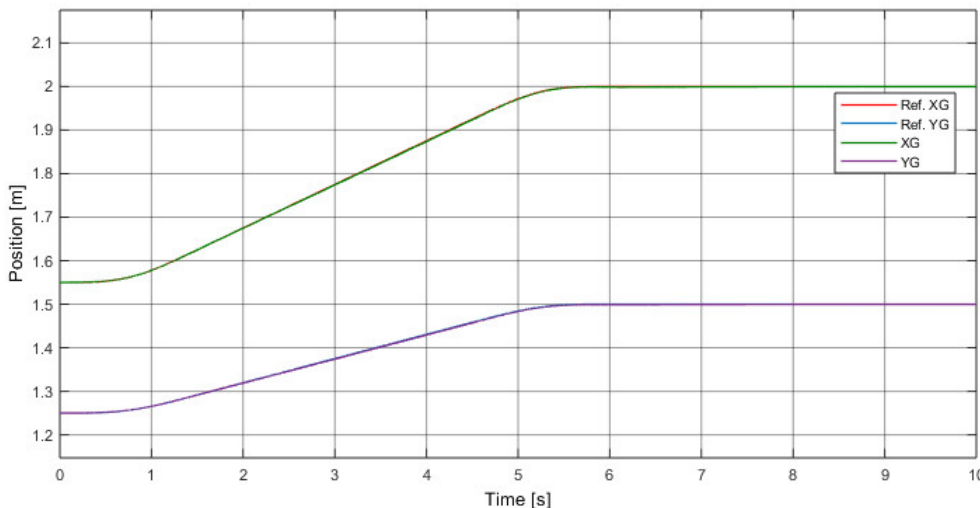
Figure 23. Planar CDPR positioning response of a fuzzy PID controller.